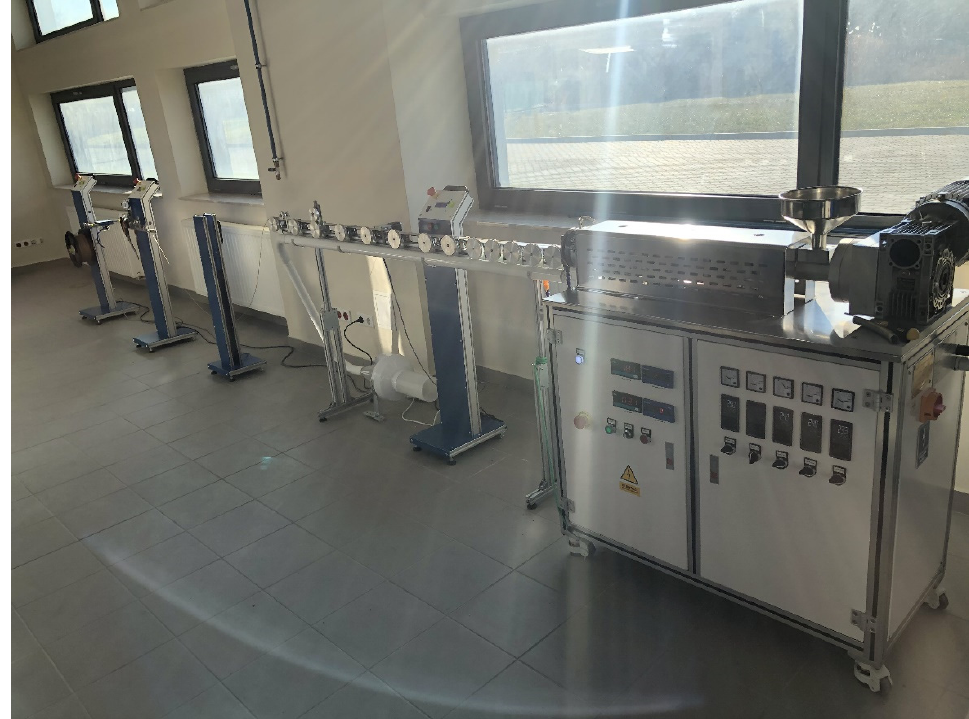
Figure 1. Proprietary technological line for obtaining filaments.